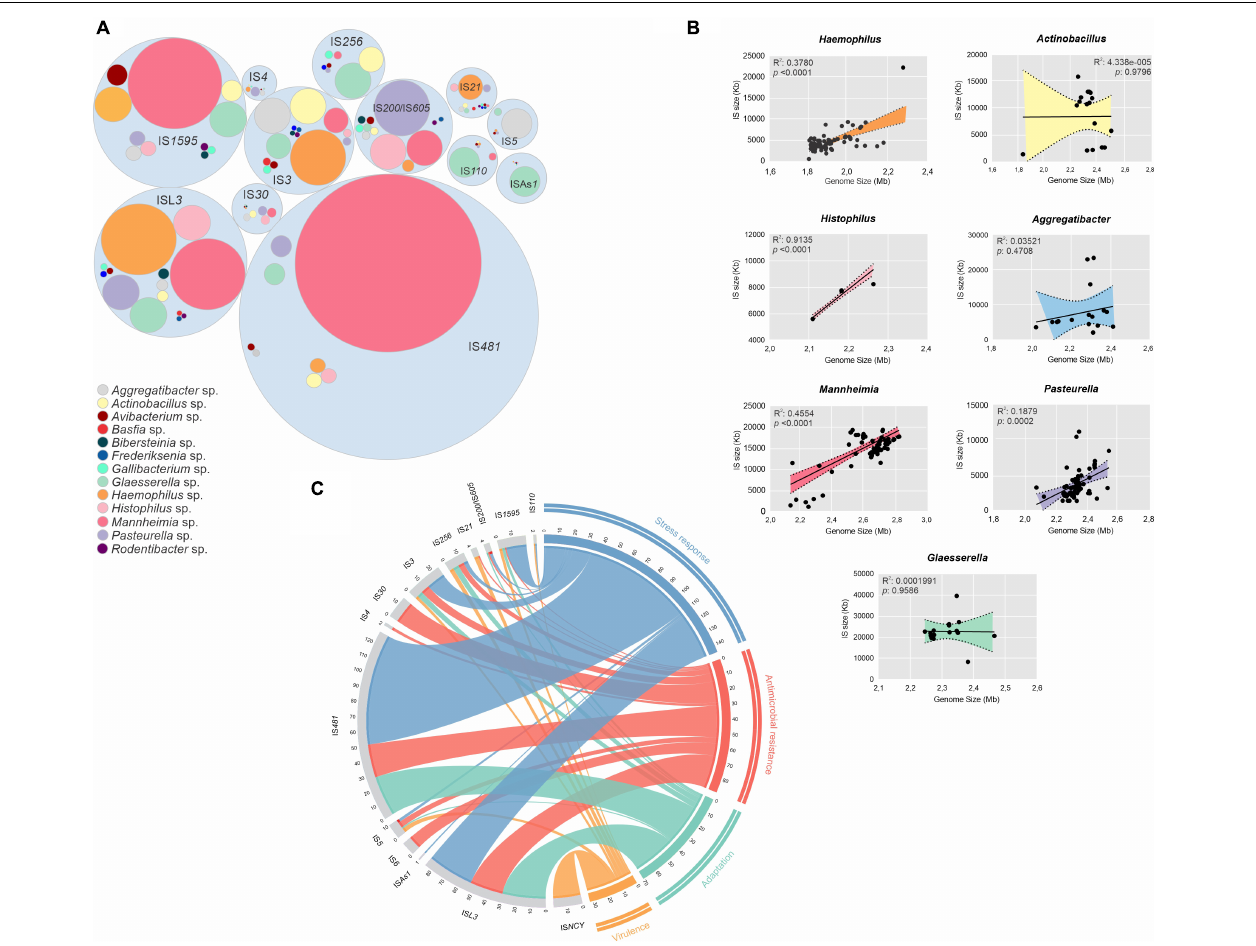
FIGURE 2 | Dissemination, impact in genome size and genetic context of insertion sequences (ISs). (A) Hierarchic organization of ISs distribution around the Pasteurellaceae species, colored by genus as shown in the legend. (B) Correlation graph between genome sizes and ISs grouped by genus. The x -axis indicates the genome size and the y-axis indicates the IS size in kilobases. Shaded regions indicate the 95% confidence interval according to the Pearson correlation coefficient. (C) Circular visualization of ISs context in four classes according to their flanking genes: Stress response, antimicrobial resistance, adaptation, and virulence (Clockwise direction). Inner connections represent the connection between IS families (anti-clockwise direction) and the function of the flanking genes. Values outside of the ring represent the total number of the IS elements from the respective